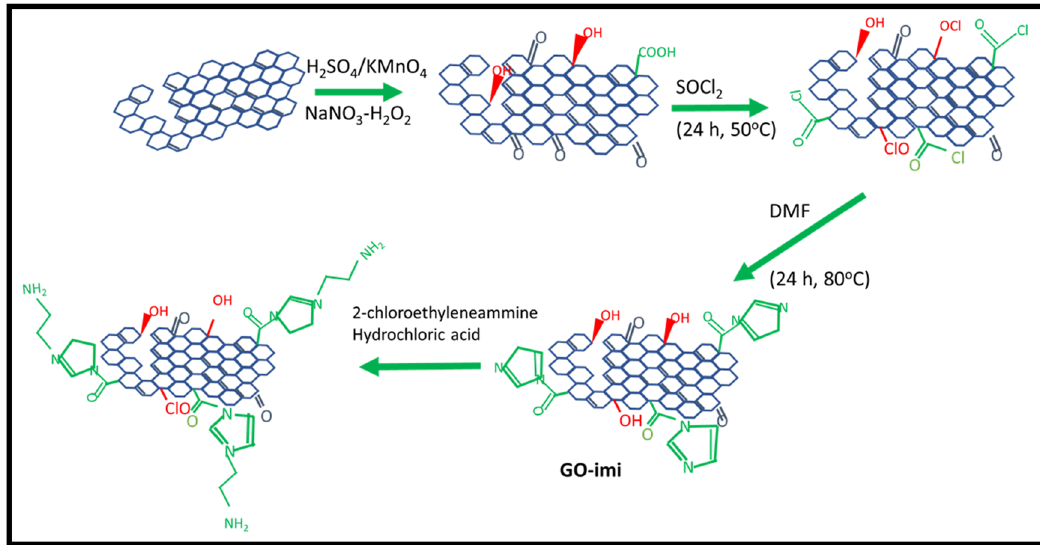
Figure 19: Schematic of synthesis process for the functionalized ( GO - imi -( CH 2 ) 2 - NH 2 ) .